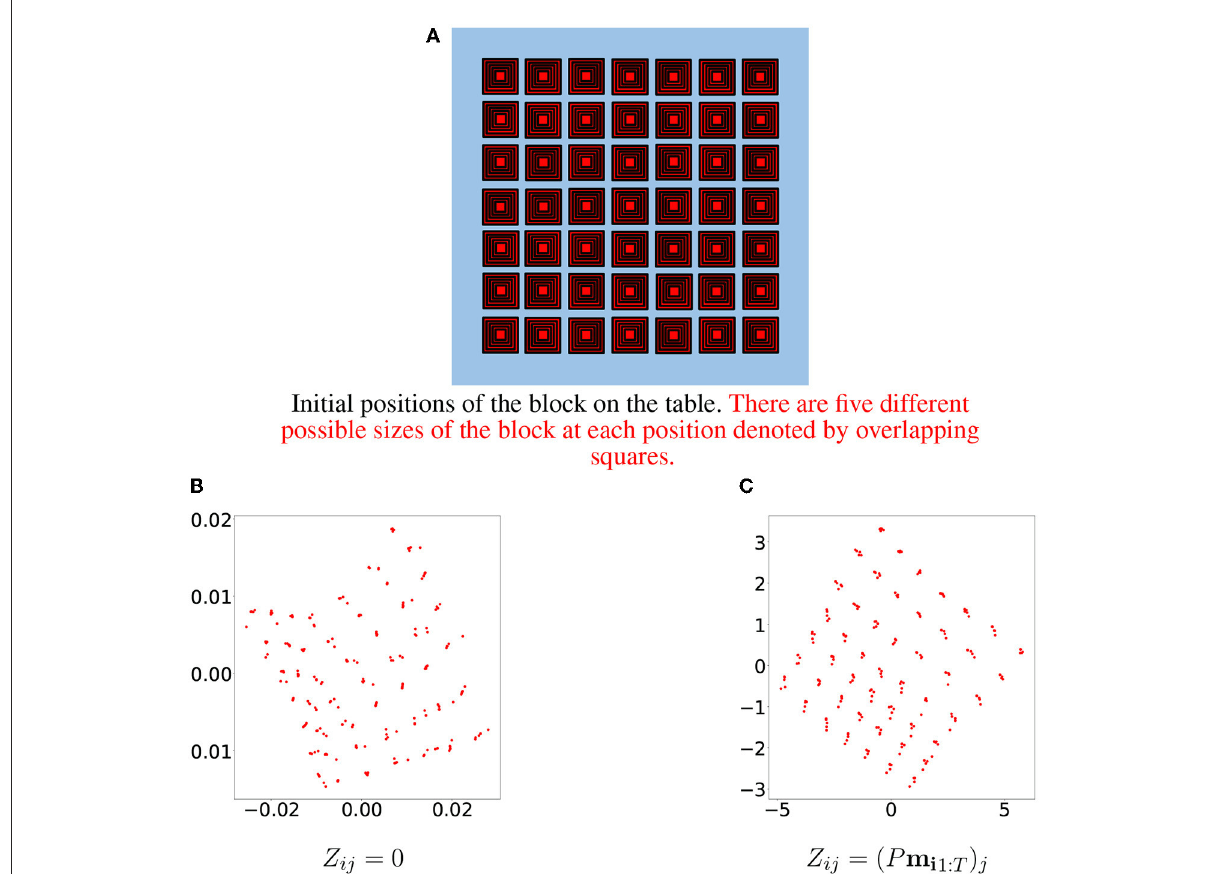
FIGURE6 Initial positions of the block are depicted in (A) . Each position corresponds to five samples differing in block size. The first two principal components of the learned latent vectors for samples belonging to one specific primitive are depicted in (B) for the zero initialization method and in (C) for the random linear projections initialization